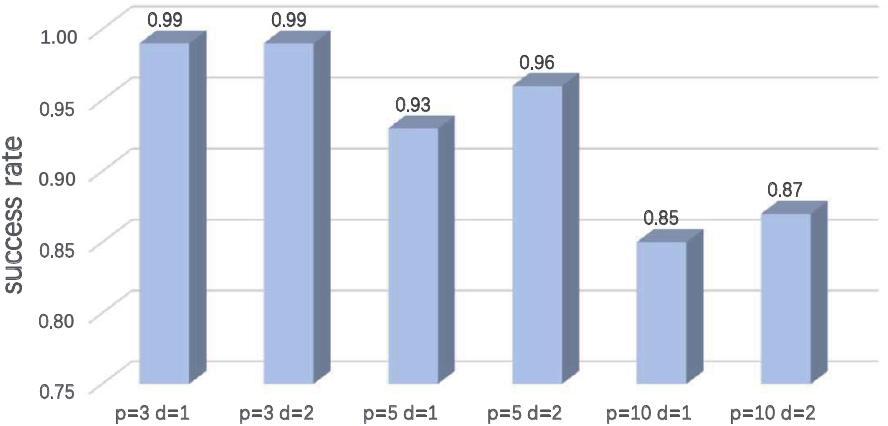
Figure 7. Navigation success rate in different